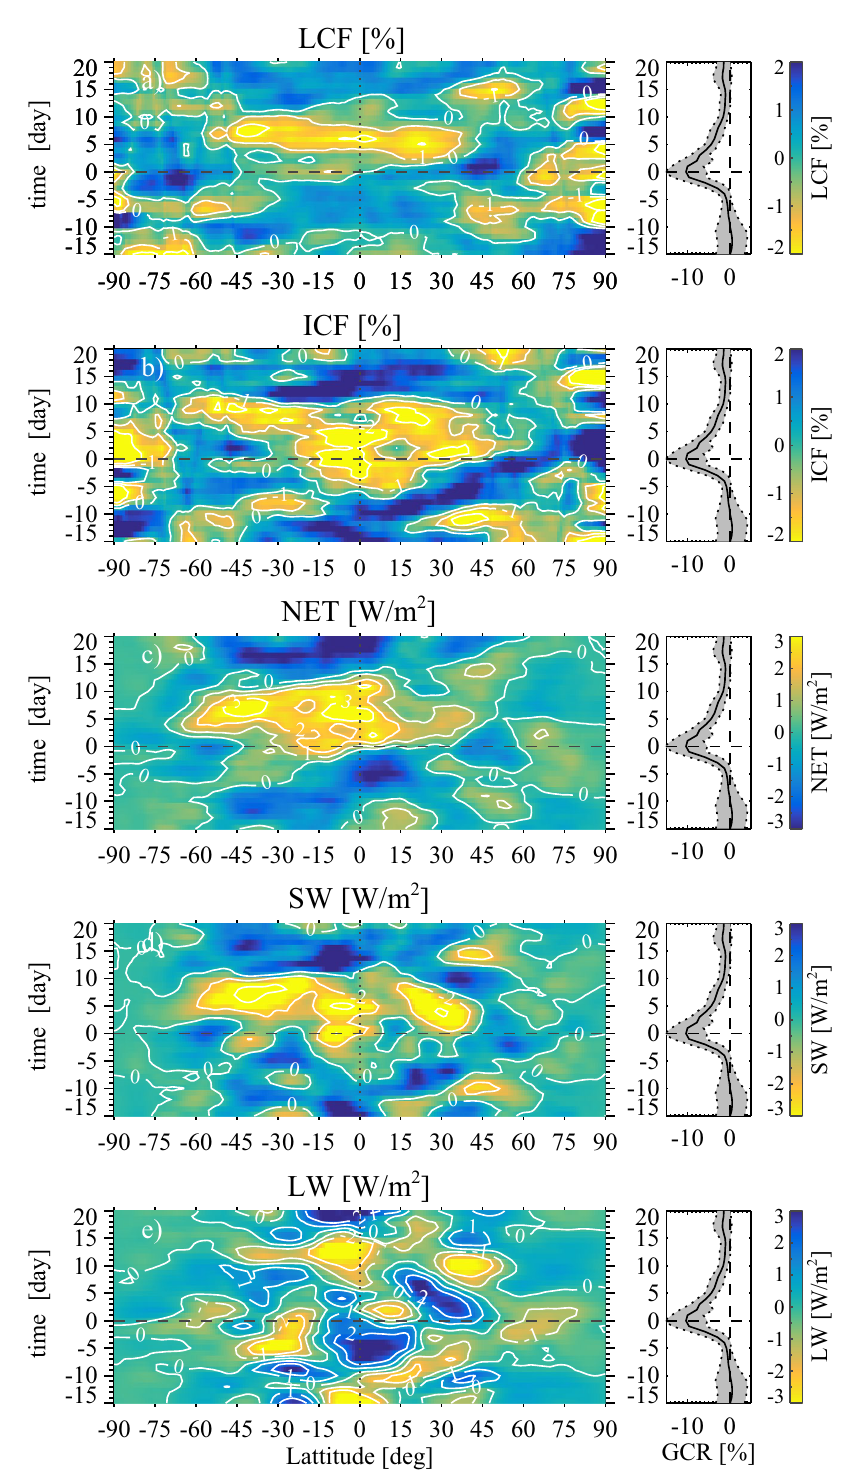
Figure 3. Maps depicting changes in clouds and TOA radiative balance as a function of latitude and time (centered on the FD minimum). The maps are superposed data from the five strongest FDs after 2000. (a) The left panel is based on liquid cloud fraction observations from MODIS in (%). The right panel in all rows displays the change in cosmic rays during the same period (black curve). (b) Left panel is ice-cloud-fraction observations 2 from MODIS in (%). (c) Left panel is TOA CERES NET radiation in (W/m ). (d) Left panel is TOA CERES SW 2 radiation in (W/m ). (e) Shows the LW similar to the SW in (d)